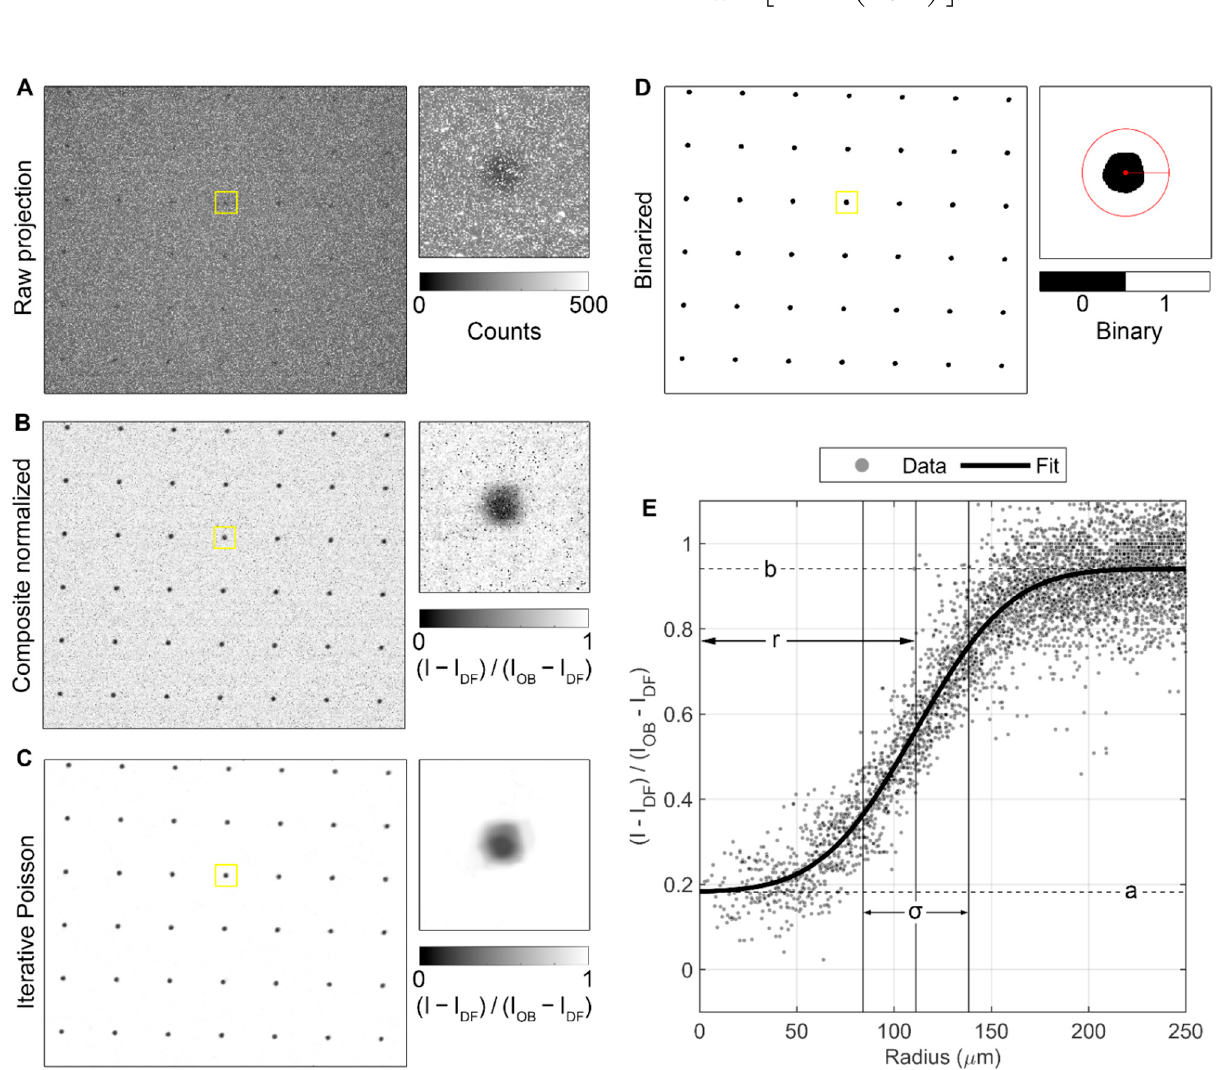
Figure 6. Image analysis pipeline demonstrated for the two-layer, 250 µ m grid pattern measured at BT2. ( A ) Raw projections contain blob and streak artifacts. ( B ) Median of five projections each of the sample, open beam, and dark frame images are used to remove artifacts and create composite normalized images, which are the sum of the transmitted and scattered neutrons. ( C ) Iterative Poisson denoising is applied to prepare the images for binarization. ( D ) Image is binarized and regions identified and filtered by size and nearness to edge of image. ( E ) Center of mass of each grid dot from D is identified, and all pixels within 2× the nominal diameter of the center are converted to radial distance and fit with an error function to compute metrics for each individual grid dot. Each of the BB grids measured at BT2, shown in Figure 7, was processed with the pipeline described above. For the BB grids measured at CG-1D, shown in Figure 8, the images were cropped to a 750 px × 750 px region after normalization and the Poisson filter was not required for binarization, but the rest of the image processing pipeline was the same. All statistics shown for measurements at both instruments were calculated using the composite normalized (unfiltered) images.